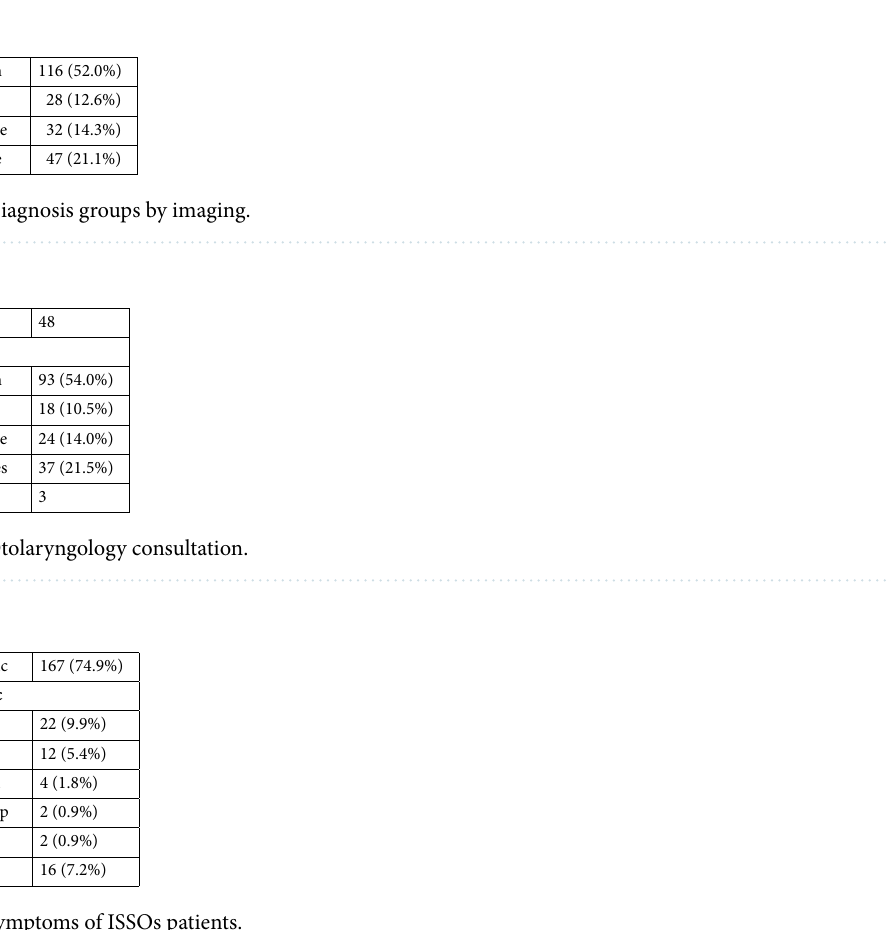
Table 5. Symptoms of ISSOs